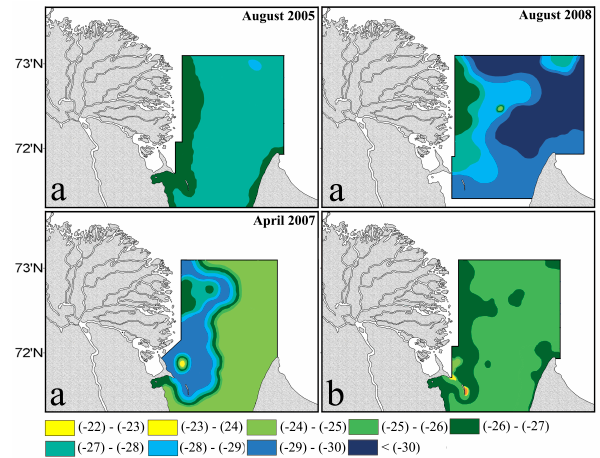
Fig. 9. Distribution of δ 13 C (‰) in water column (a) and bottom sediments (b) , combined 2000, 2005, 2007 and 2008